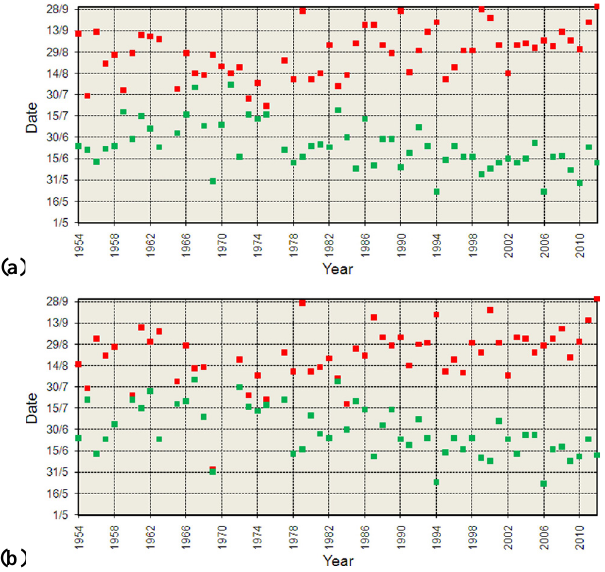
Fig. 4. Inter-annual variation of duration of PMV ≥ 2 summer dis- comfort in Athens at 14:00 for (a) calm and (b) light wind condi- tions for the period 1954–2012 (smoothing and trends as in Fig.